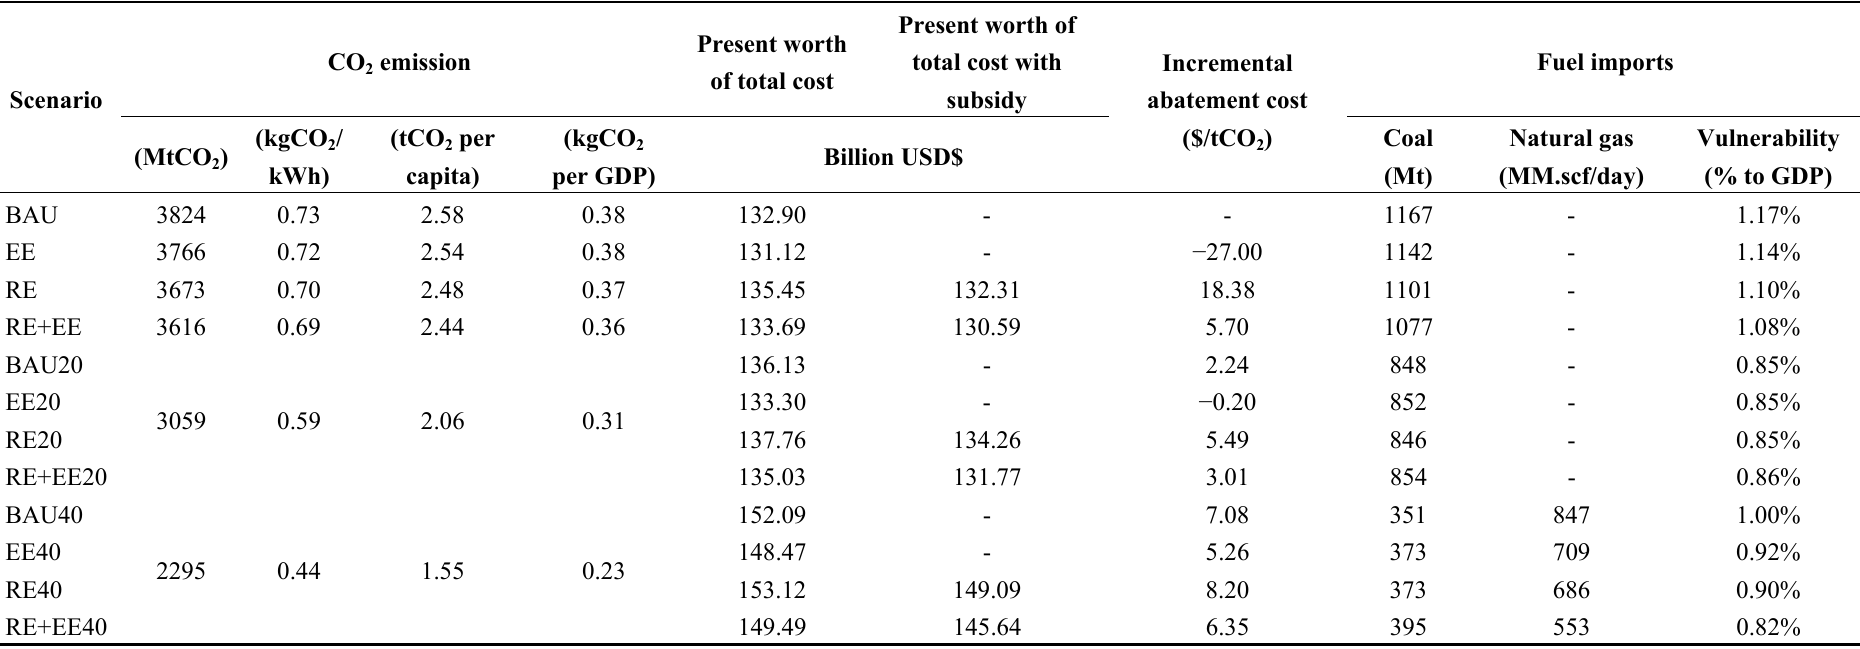
emissions and fuel import 2